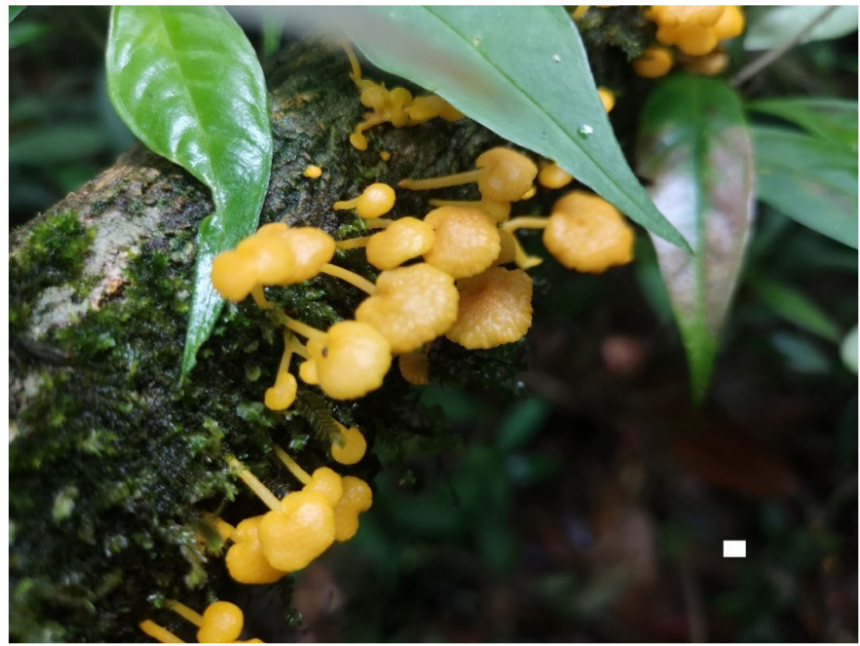
Figure 10. Fresh basidiocarps of Favolaschia longistipitata (Holotype). Scale bar = 10 mm.